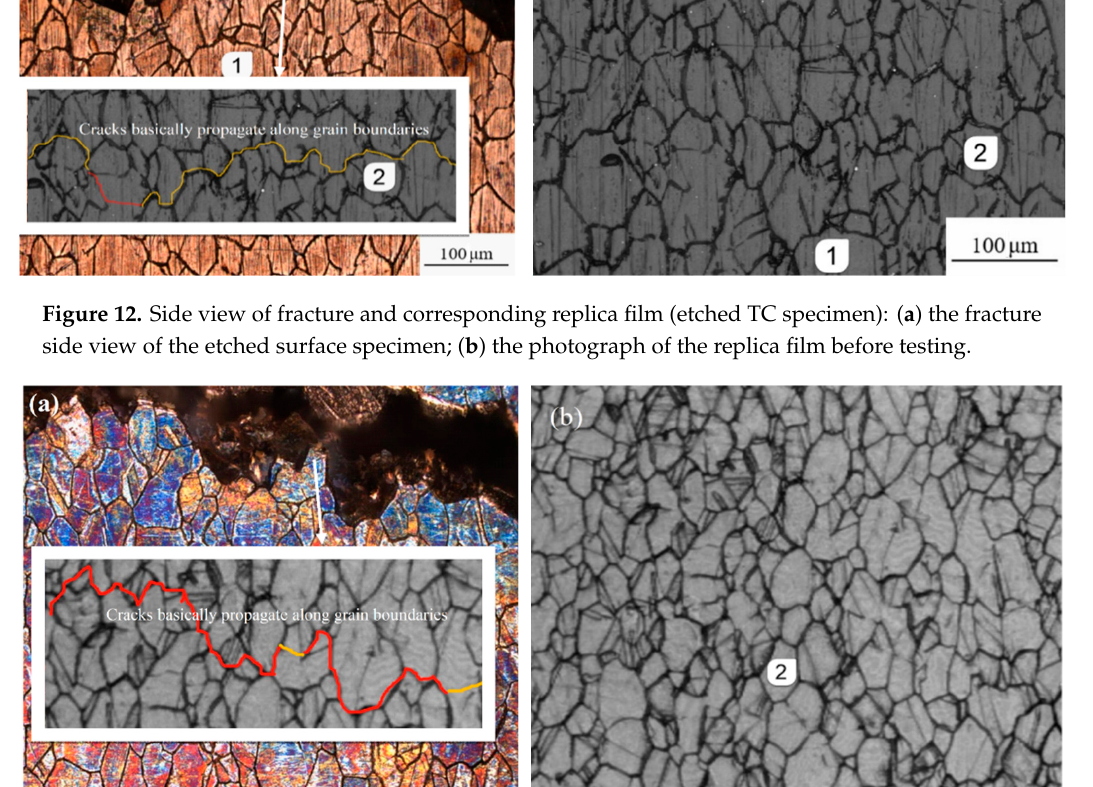
Figure 13. Side view of fracture and corresponding replica film (etched RB specimen): ( a ) the fracture side view of the etched surface specimen; ( b ) the photograph of the replica film before testing.